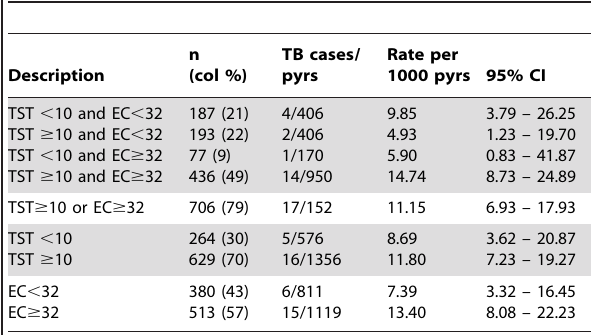
Table 6. Incidence rates by TST and EC response (restricted to those with both TST and EC response data, n